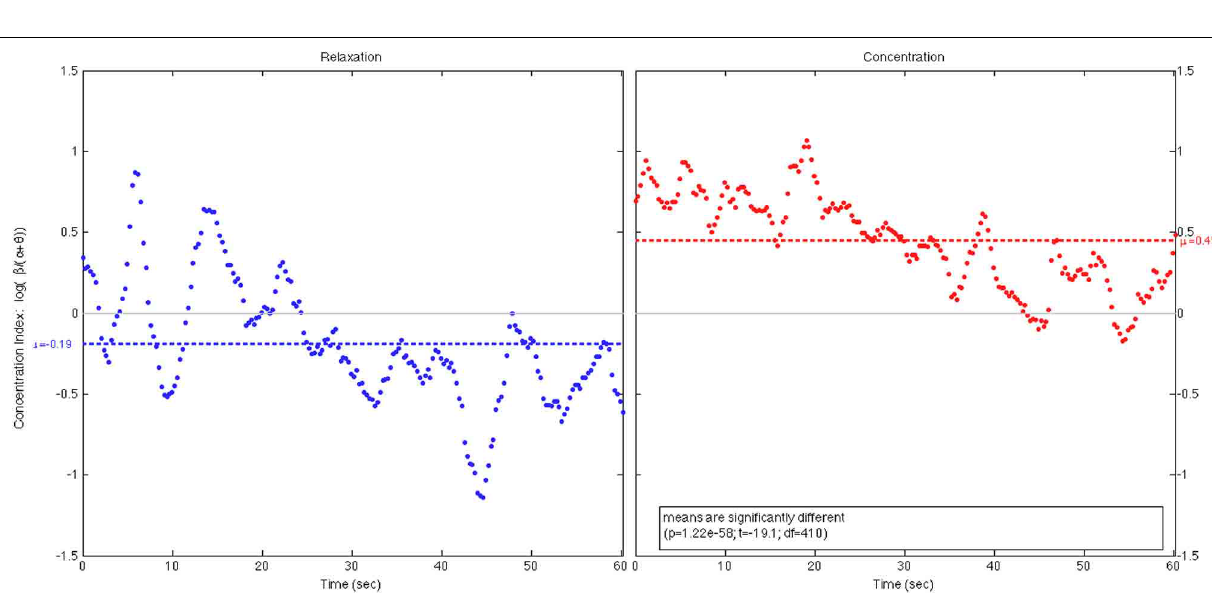
Closed-Loop) BCI and Adaptive BCI. Each scenario represents an incremental enhancement of system